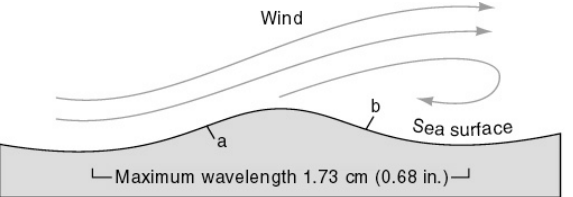
Waves that are generated from the wind blowing over the sea surface are known as wind waves (Mitsuyasu, 2015).The typical wavelength produced by these wind waves is 60-150 m depending on the strength of the wind forces towards the ocean surface. The factors that affect the wind wave generation are wind strength, wind duration and fetch. Fetch can be defined as the uninterrupted distance over which the wind is blowing without changing directions. Figure 4 illustrates the formation of waves by the winds.